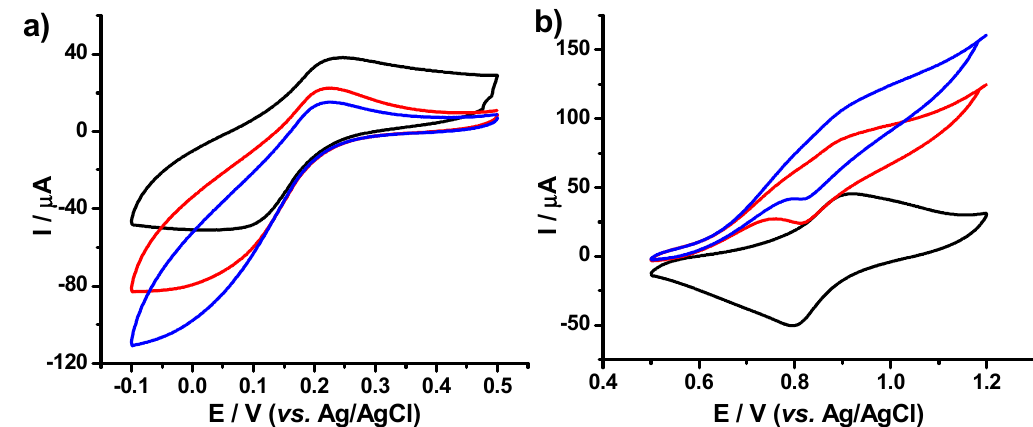
Figure 8. Cyclic voltammograms of H 2 O 2 at PB–TiO 2 / fCNT / GC electrode, in the PB redox reactions of low-spin Fe(CN) 63 − /4 − ( a ) and the PB redox reactions of high-spin Fe 3+/2+ ( b ) with a scan rate of 50 mV ∙ s − 1 in PB buffer; without H 2 O 2 (black line), 1 mol · L − 1 H 2 O 2 (red line), and 2 mol · L − 1 H 2 O 2 (blue line).